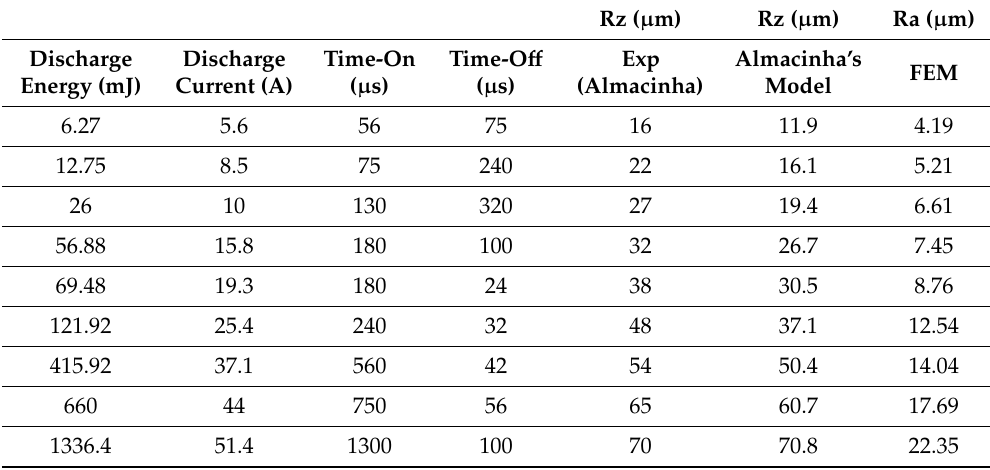
Figure 11. Comparison of surface roughness obtained from a numerical model and experimental values from Salonitis [29]. Table 3. Comparison of surface roughness from our numerical model and experimental values from Almacinha [22] and the corresponding performance parameter.